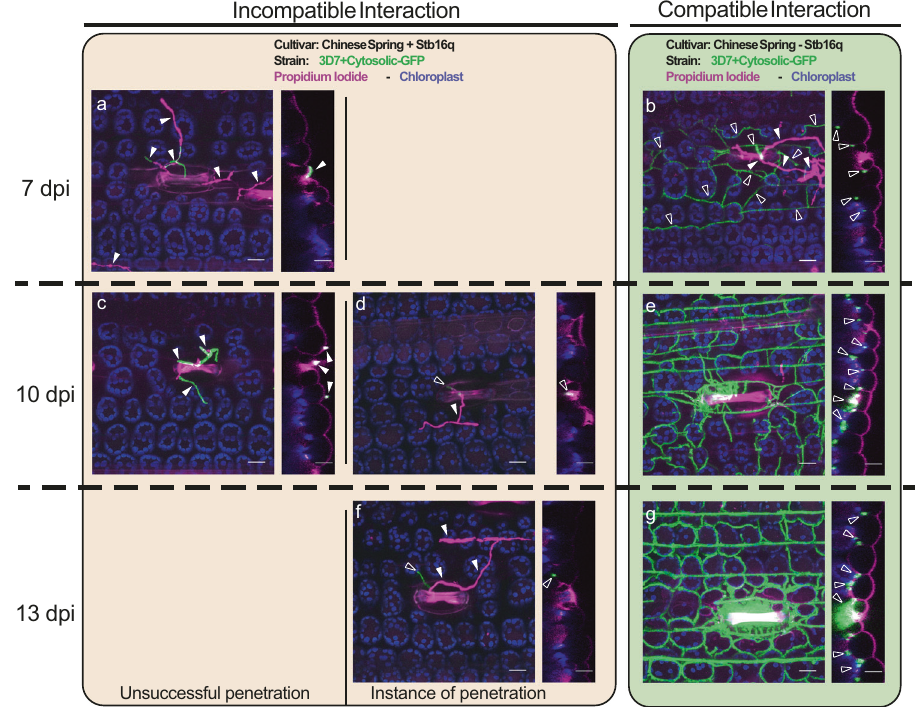
Fig. 3 Zymoseptoria tritici infection during compatible and incompatible interactions using wheat near isogenic lines carrying the Stb16q gene. Leaf surfaces and leaf cross sections of Chinese Spring carrying or not Stb16q were observed using a confocal at three time points after infection (7, 10, and 13 dpi) with the Stb16q avirulent GFP-labeled Z. tritici isolate 3D7. Epiphyllous and penetrating hyphae, shown in green or in purple when they were stained by propidium iodide, are marked by full and empty white triangles, respectively. At 7 dpi, in the incompatible reaction (CS with Stb16q ), the fungus is observed only at the leaf surface and no instance of penetration was recorded ( a ). At 10 dpi, some instances of penetration were observed ( d ) and by 13 dpi, hyphae start growing inside the substomatal cavity ( f ). In the compatible interaction (CS without Stb16q ), by 7 dpi the fungus hyphae colonized the mesophyll ( b ). By 10 and 13 dpi, it formed a dense network and began to fi ll the substomatal cavities and to form pycnidia ( e , g ). Images a – g are maximum projections. The corresponding orthogonal views ( yz ) are shown in the narrow panels to the right of each main image. Scale bars represent 20 µ m. The auto fl uorescence of the chloroplasts is shown in purple and the cell walls stained with propidium iodide in pink. The experiment was performed twice ( n = 2). In the fi rst replicate, infected leaves were collected at 6 and 9 dpi while they were collected at 7, 10, and 13 dpi in the second replicate. Both replicates show the same